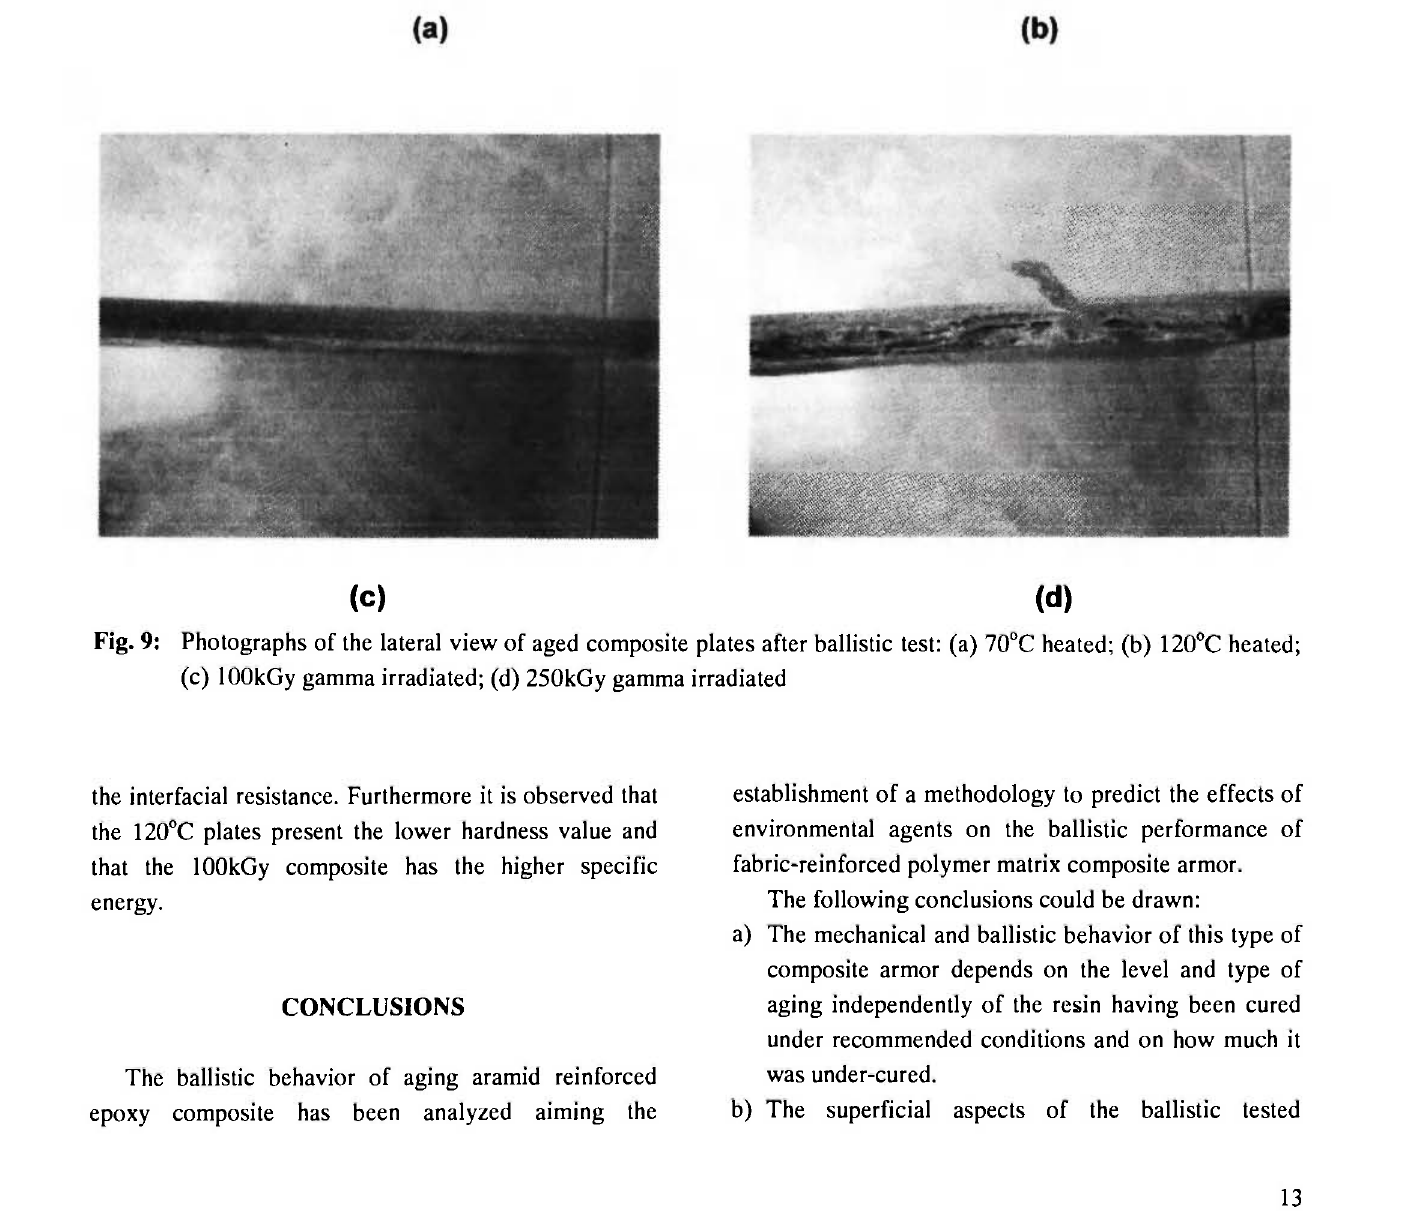
the interfacial resistance. Furthermore it is observed that the 120°C plates present the lower hardness value and that the lOOkGy composite has the higher specific